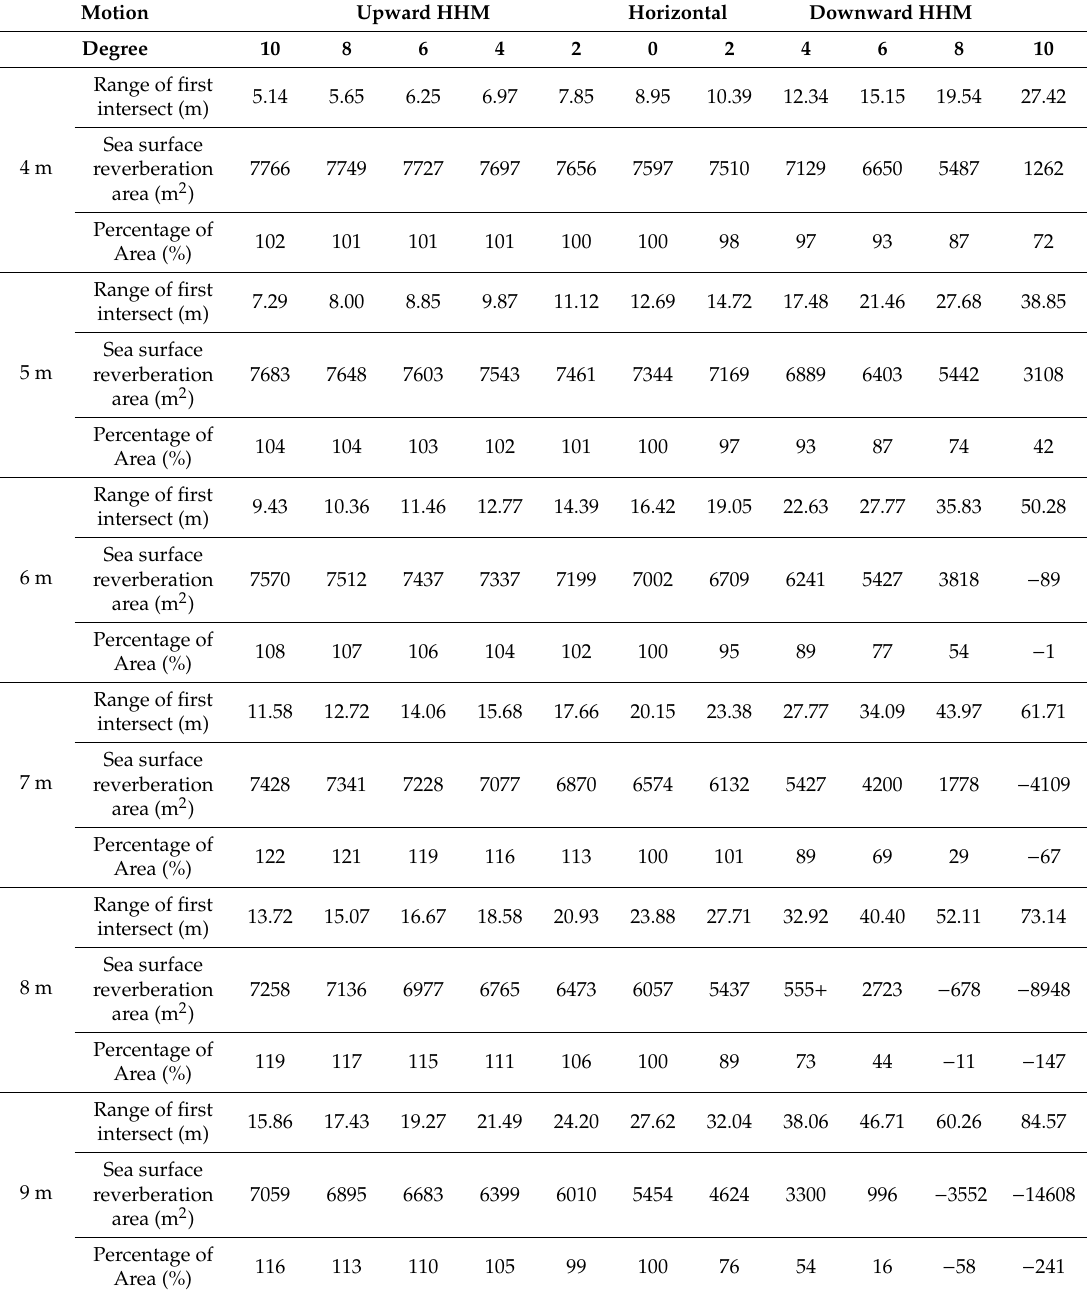
Table 3. Correlation between the angle of HHM and sonar operation